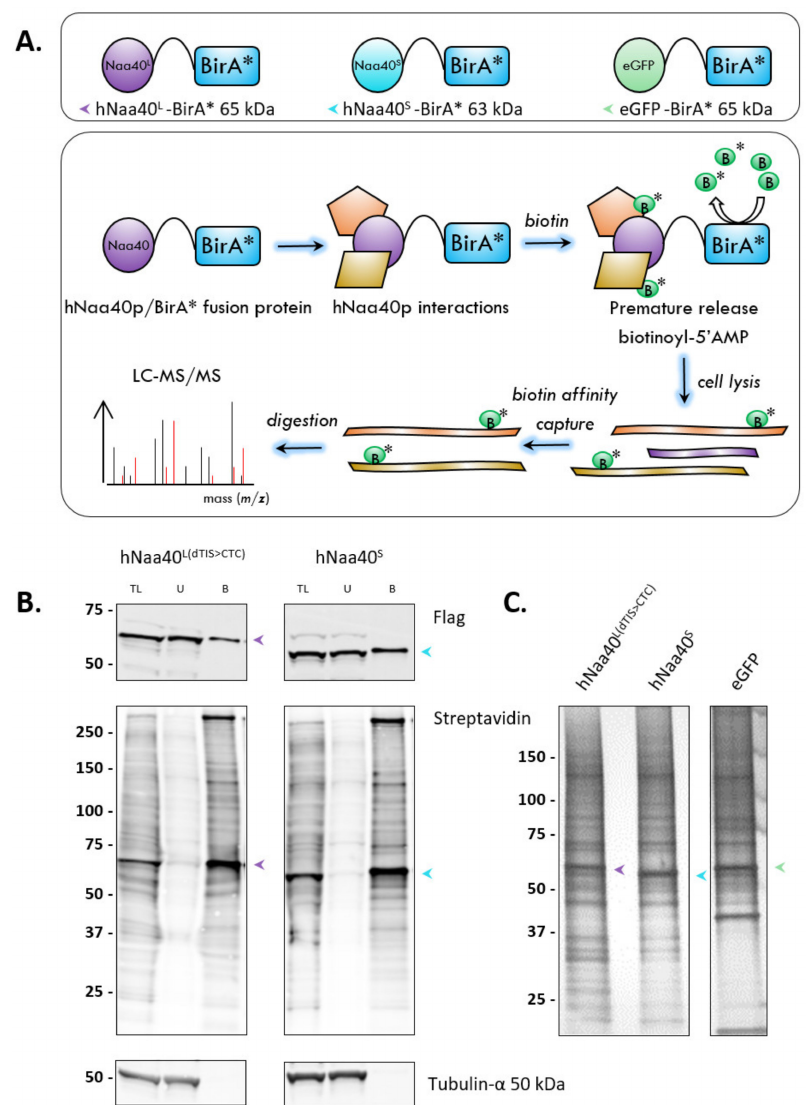
Figure 8. Proximity-dependent biotin identification (BiolD) for the discovery of differen- tial hNaa40p proteoform interactors in Flp-In T-REx 293 cells. ( A ) Overview of the BiolD (setups) and MS analysis workflow. Biological replicate samples were prepared for all 3 se- tups analyzed (i.e., biological replicate samples of stable cell lines with doxycycline (DOX) induced expression of eGFP, hNaa40 L and hNaa40 S BirA* fusion proteins) ( B ) Western blot analysis showing expression and (partial) biotinylation of hNaa40 L and hNaa40 S BirA* fusion proteins, and specific enrichment of biotinylated hNaa40p proteoforms following streptavidin affinity capture. TL = total lysate, U = unbound fraction and B = bound fraction. Purple, light blue and green arrows indicate hNaa40 L , hNaa40 S and eGFP-BirA* fusion proteins, respectively. The equivalents protein input of 50 and 200 µ g ‘TL’ was analyzed for ‘TL’ and ’U’, and ‘B’ fractions, respectively. (C) Silver staining of biotinylated proteins following streptavidin purification (representative gel is shown). ~1.5% of total eluate sample corresponding to the input material of ~10 6 cells was